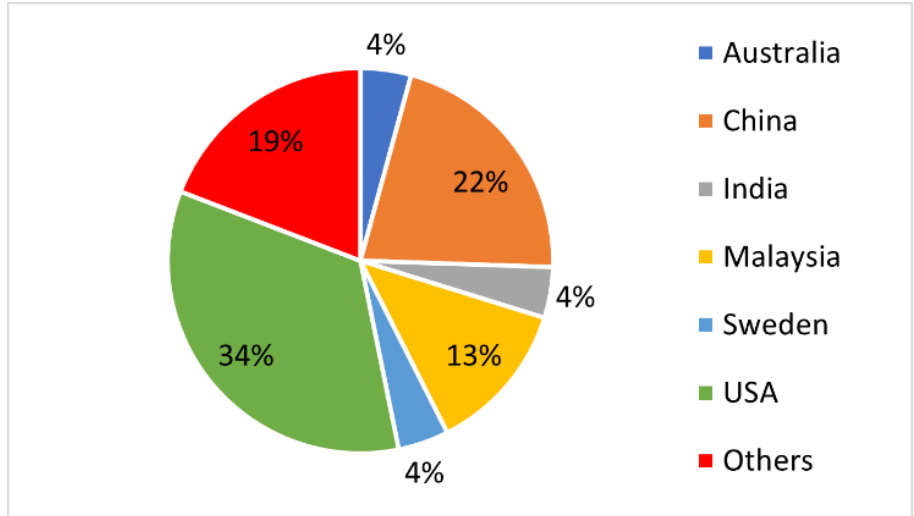
Figure 6. Thermal energy harvesting research articles across countries.